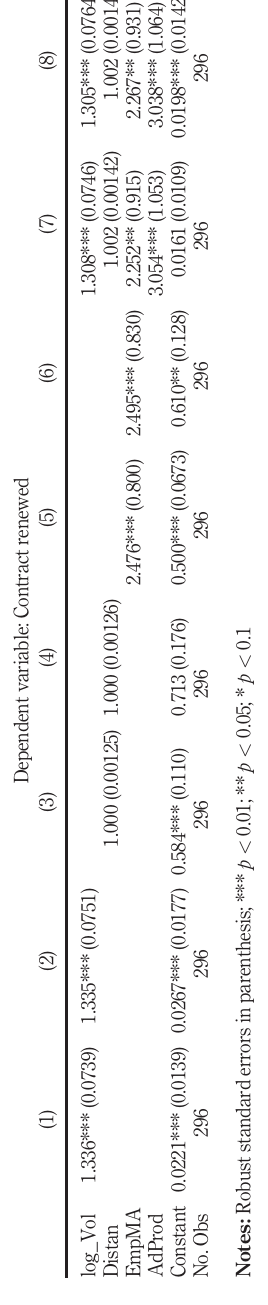
Table VII. Results (logit